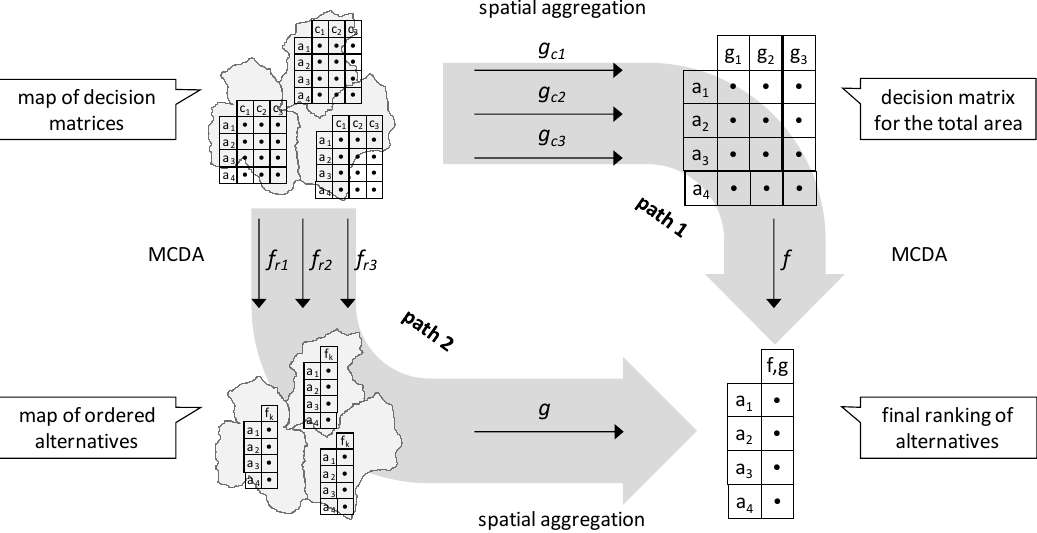
Figure 1. Graphical illustration of the two pathways for spatial multi-criteria aggregation evaluating the relative performance of alternatives based on spatial information (modified from Reference [6]).